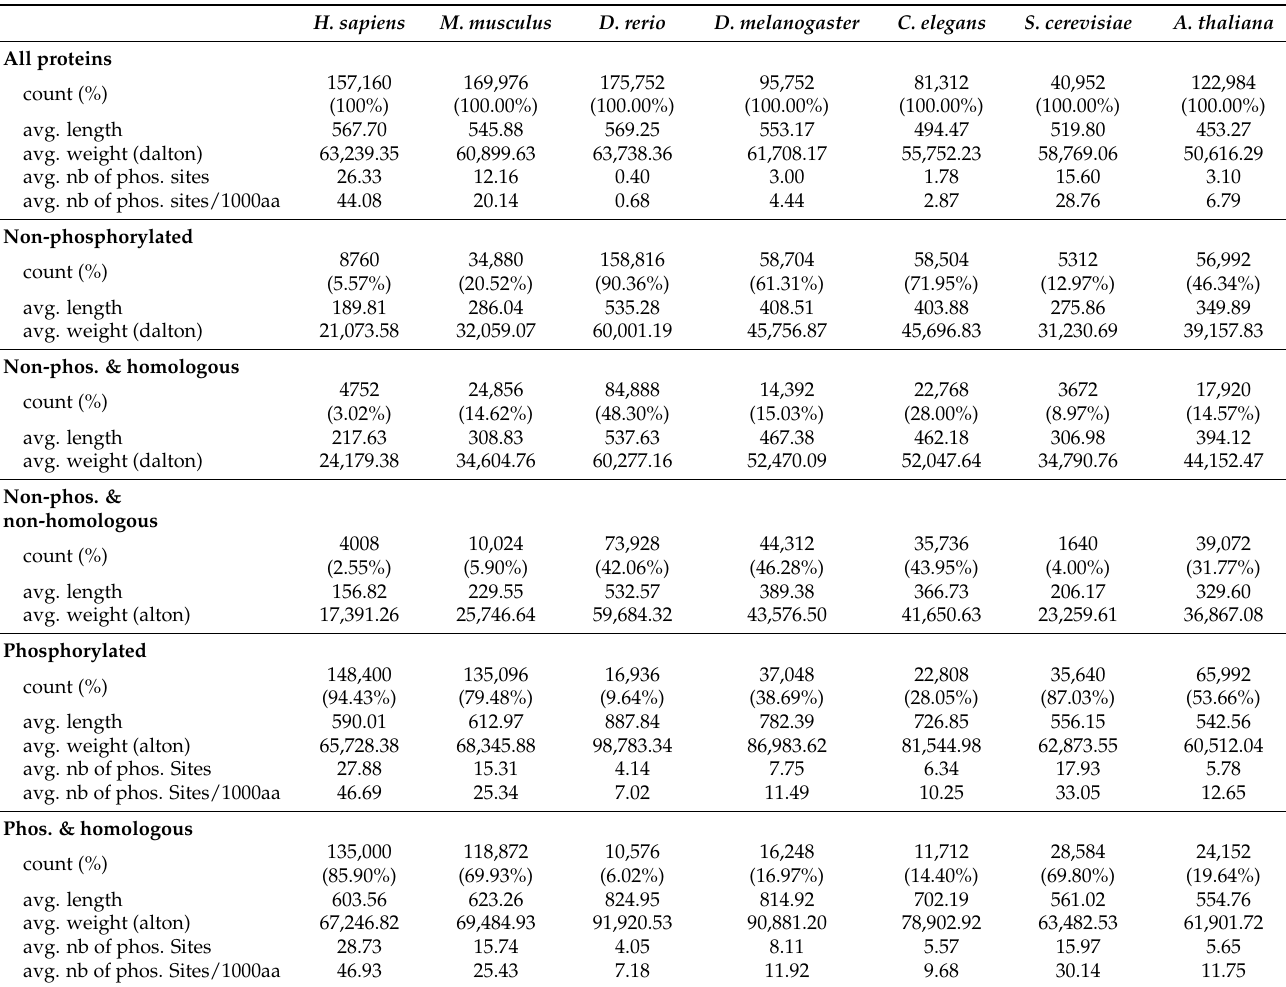
Table 1. Statistics about the proteins of the seven studied species.